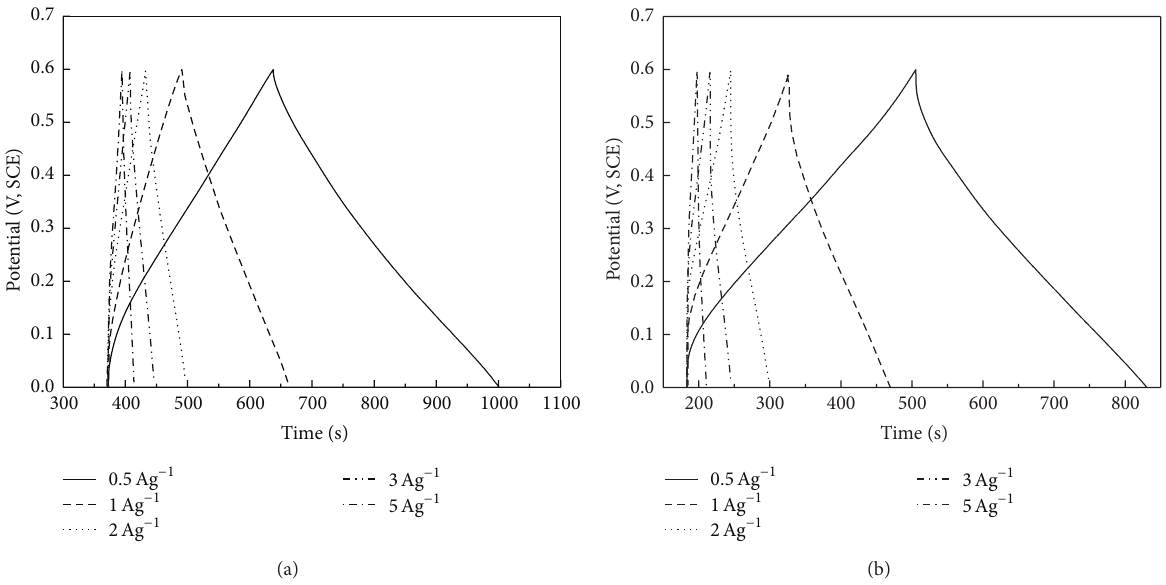
Figure 3: Charge/discharge curves of PANI in 1MHCl (a) and 1MH 2 SO 4 (b) at different current densities of 0.5, 1, 2, 3, 5Ag −1 .